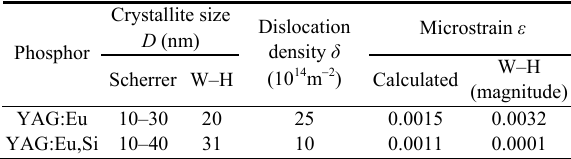
Table 1 Structural parameters of YAG:Eu